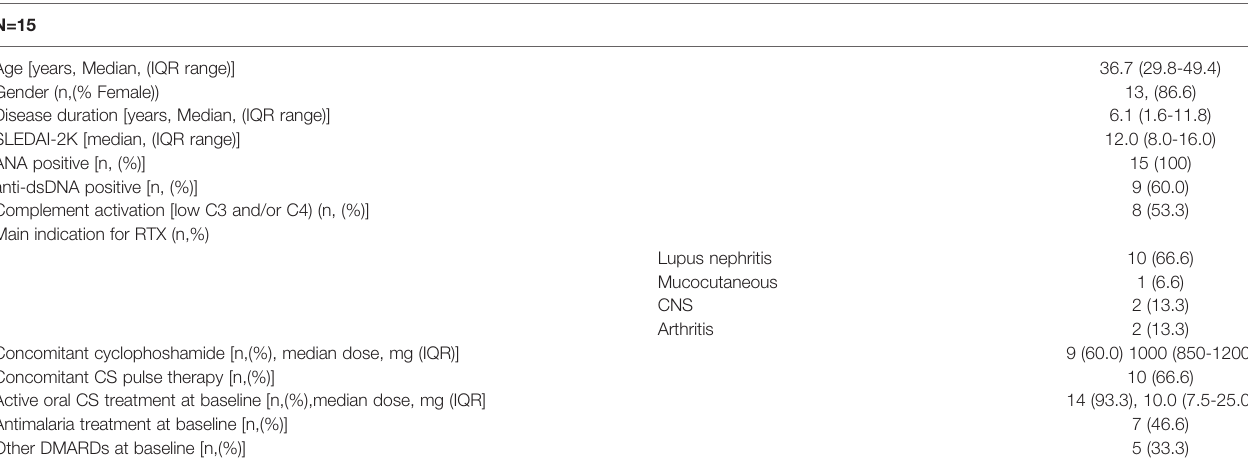
Table 1 , N, number; IQR, interquartile range; SLEDAI-2K, SLE disease activity index 2000; ANA, anti-nuclear antibodies; anti-dsDNA, anti-double strand DNA antibodies; RTX, rituximab; CNS, central nervous system; CS, corticosteroids; DMARDs, disease modifying anti-rheumatic drugs.